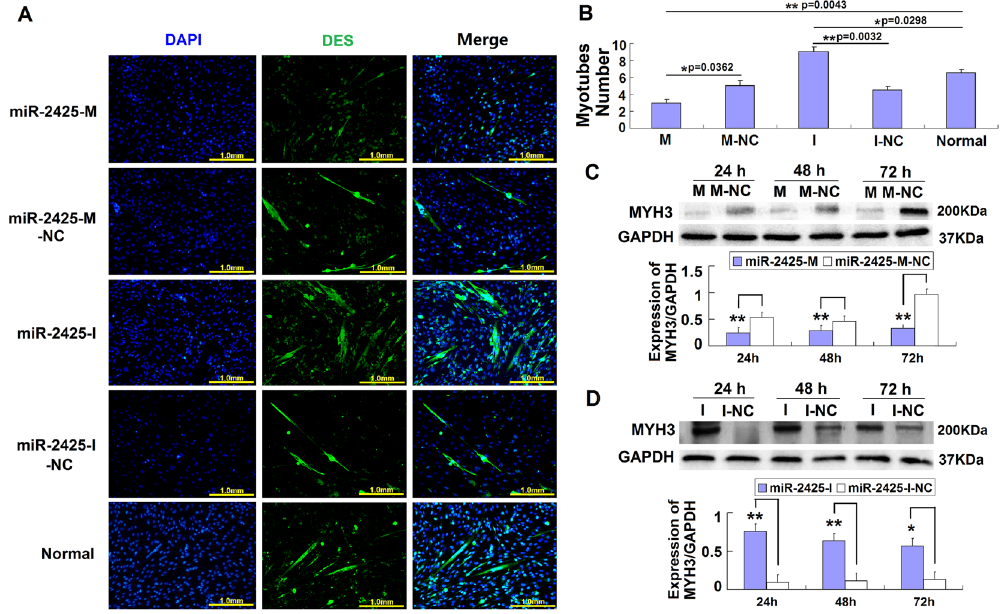
Figure 3. MiR-2425-5p inhibits MDSCs differentiation. ( A ) DES immunofluorescence (green) in MDSCs. The cells were transfected with miR-2425-M, miR-2425-M-NC, miR-2425-I, miR-2425-I-NC, and Normal (MDSCs without any treatment), then differentiated using 2% horse serum for 72 h. Magnification, 200 × . ( B ) Quantification of myotubes according to the DES staining presented in A. ( C ) MYH3 expression in MDSCs treated with miR-2425-M vs. controls at 24 h, 48 h, and 72 h. ( D ) MYH3 expression in MDSCs treated with miR- 2425-I vs. controls at 24 h, 48 h, and 72 h. * P < 0.05, ** P < 0.01, NS: no significant